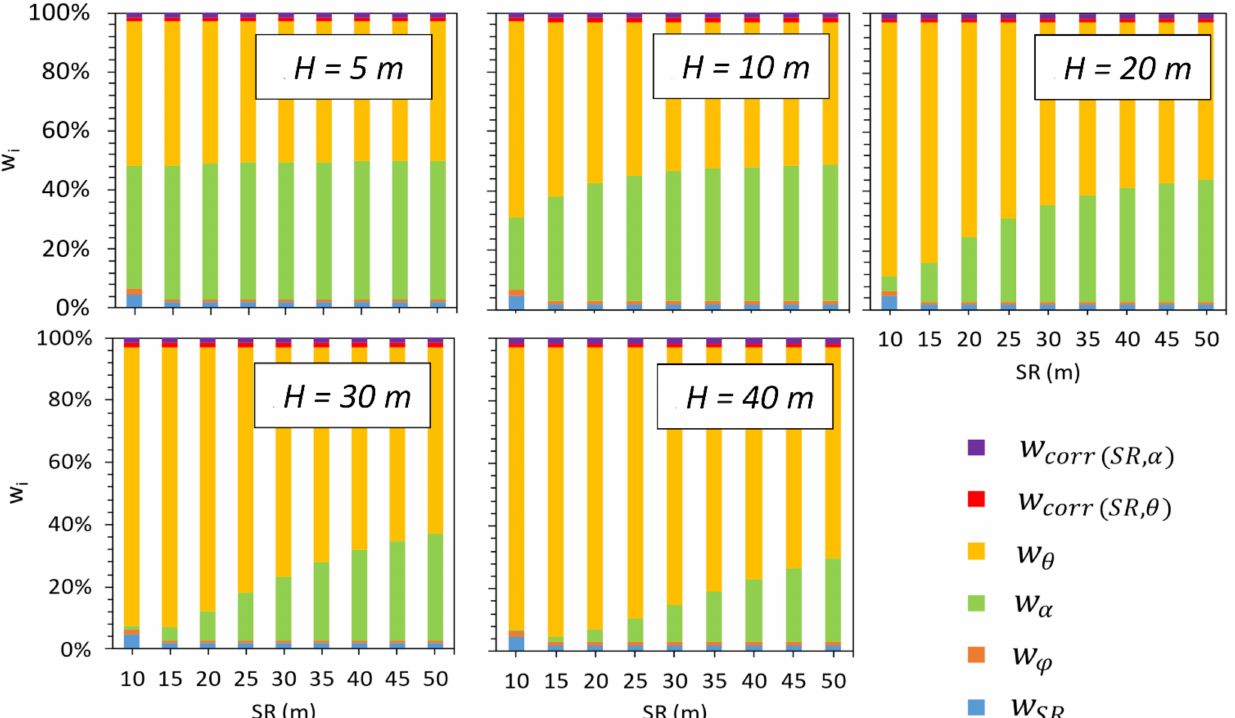
Figure 7. Relative weights (importance) of factors involved in the sensitivity analysis of σ H 2 . Sensi- tivity analysis was iteratively performed by computing w i changing H and SR